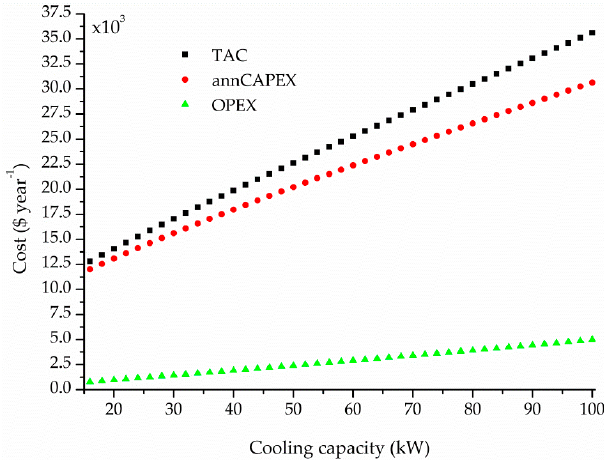
Figure 2. Optimal values of the TAC, annCAPEX, and OPEX versus cooling capacity.